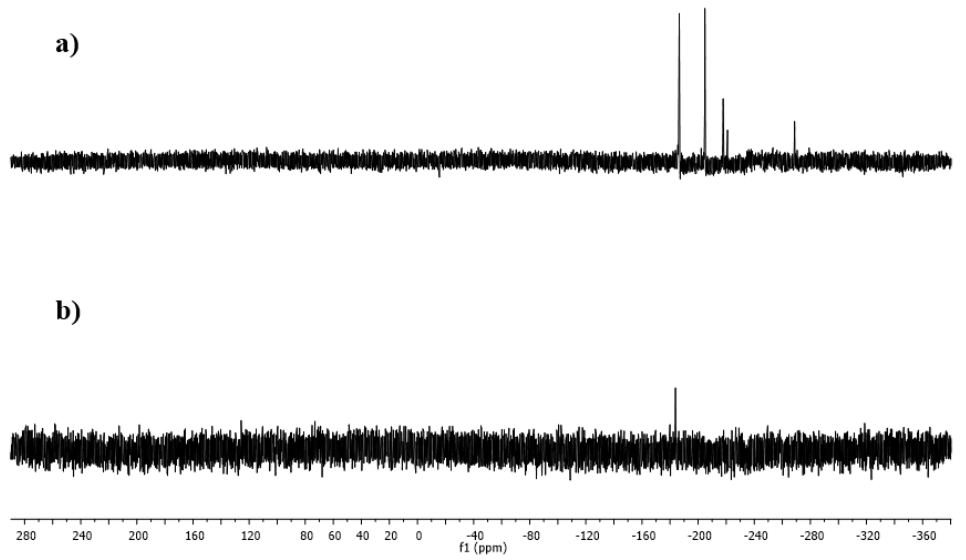
119 Sn NMR (C 6 D 6 ) spectrum of 15